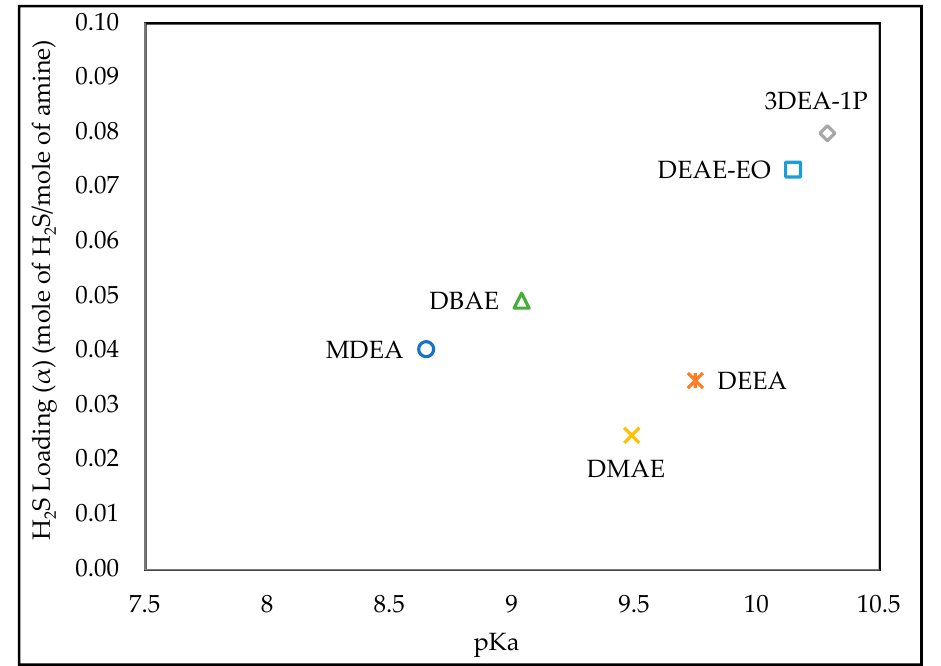
Figure 5. Effect of pKa on H 2 S loading in amine-TEG solutions; T = 5 °C ± 0.1 °C; pH 2 S = 1 kPa; amine concentration = 20 wt.% (unloaded); DBAE solutions makes two phases.